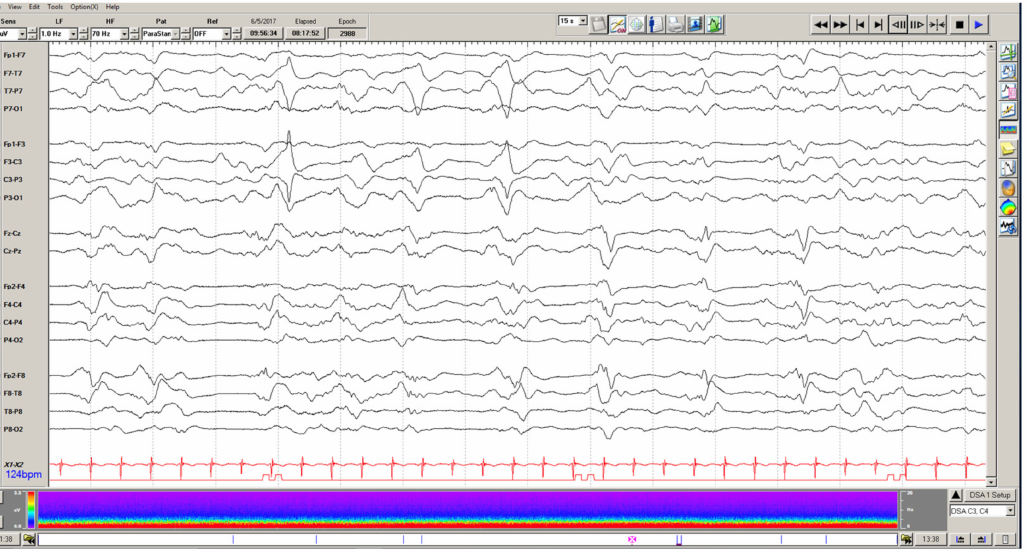
Figure 2. Generalized periodic discharges in a 7-year-old, previously healthy female with a grazing gunshot wound to the left posterior aspect of her head. EEG demonstrates evolution from a burst suppression pattern to an invariant pattern of periodic discharges happening every 2